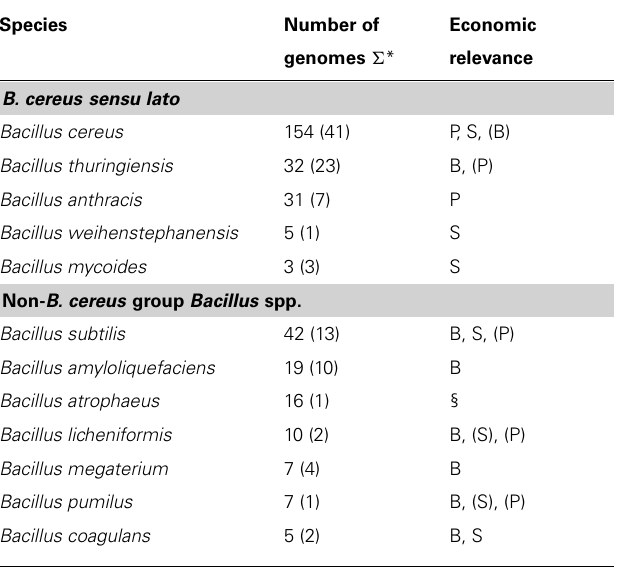
Table 1 | Overview on Bacillus species for which multiple genomes are public available (http://www.ncbi.nlm.nih.gov/genome, last accessed January